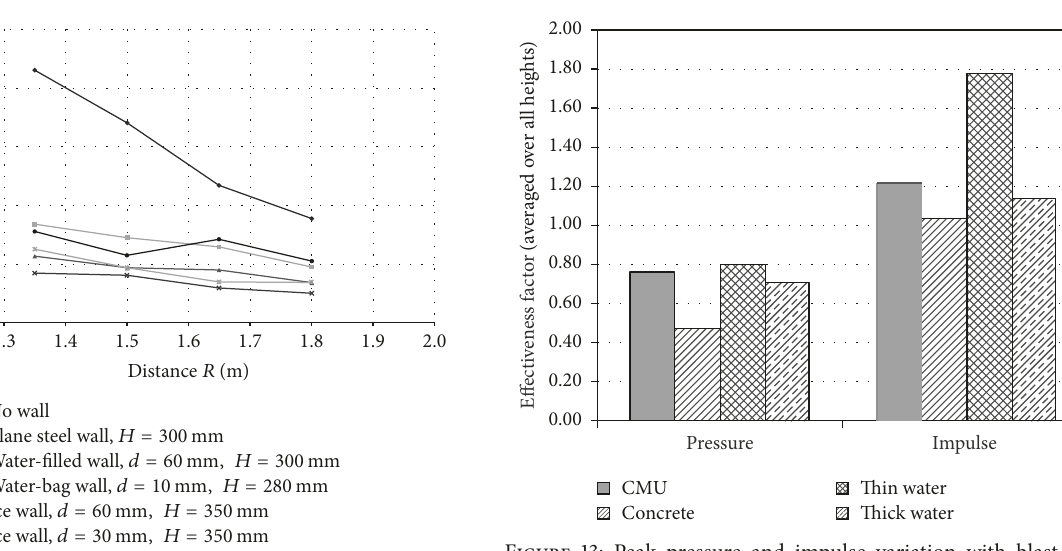
Figure 12: Peak pressure attenuation with different blast wall.